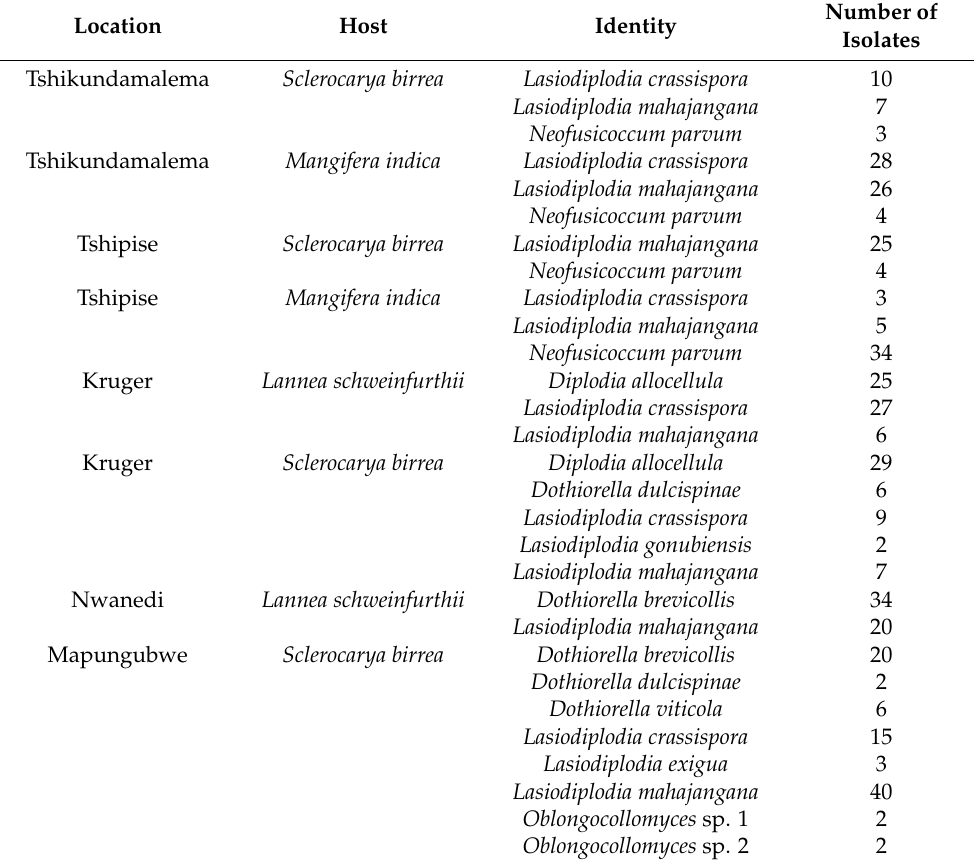
Table 5. Number of Botryosphaeriaceae isolates identified based on morphological and phylogenetic